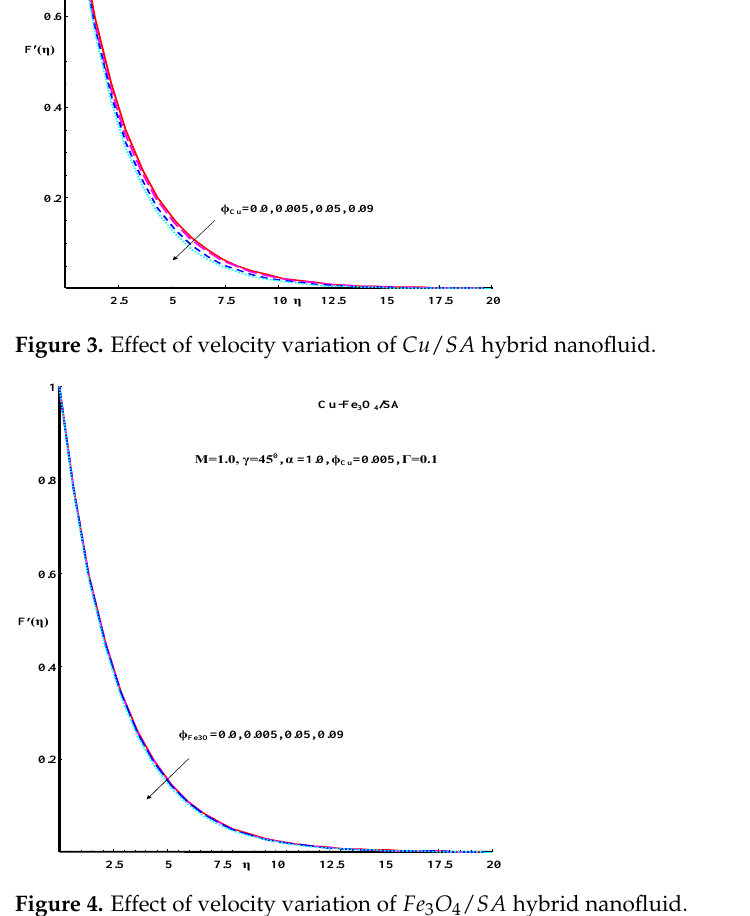
Figure 4. Effect of velocity variation of Fe 3 O 4 / SA hybrid nanofluid.